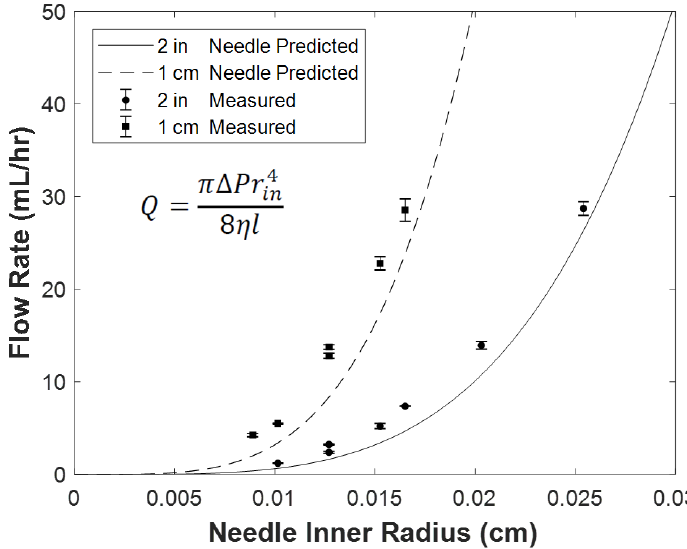
Figure 6. Flow rates increase exponentially as a function of needle inner radius. The viscosity of 2.25% ( w / v ) alginate was measured to be 330 mPas and used to calculate the predicted curves. The flow rate is proportional to the 4th power of needle inner radius in agreement with the Hagen Poiseuille Equation (Appendix A).